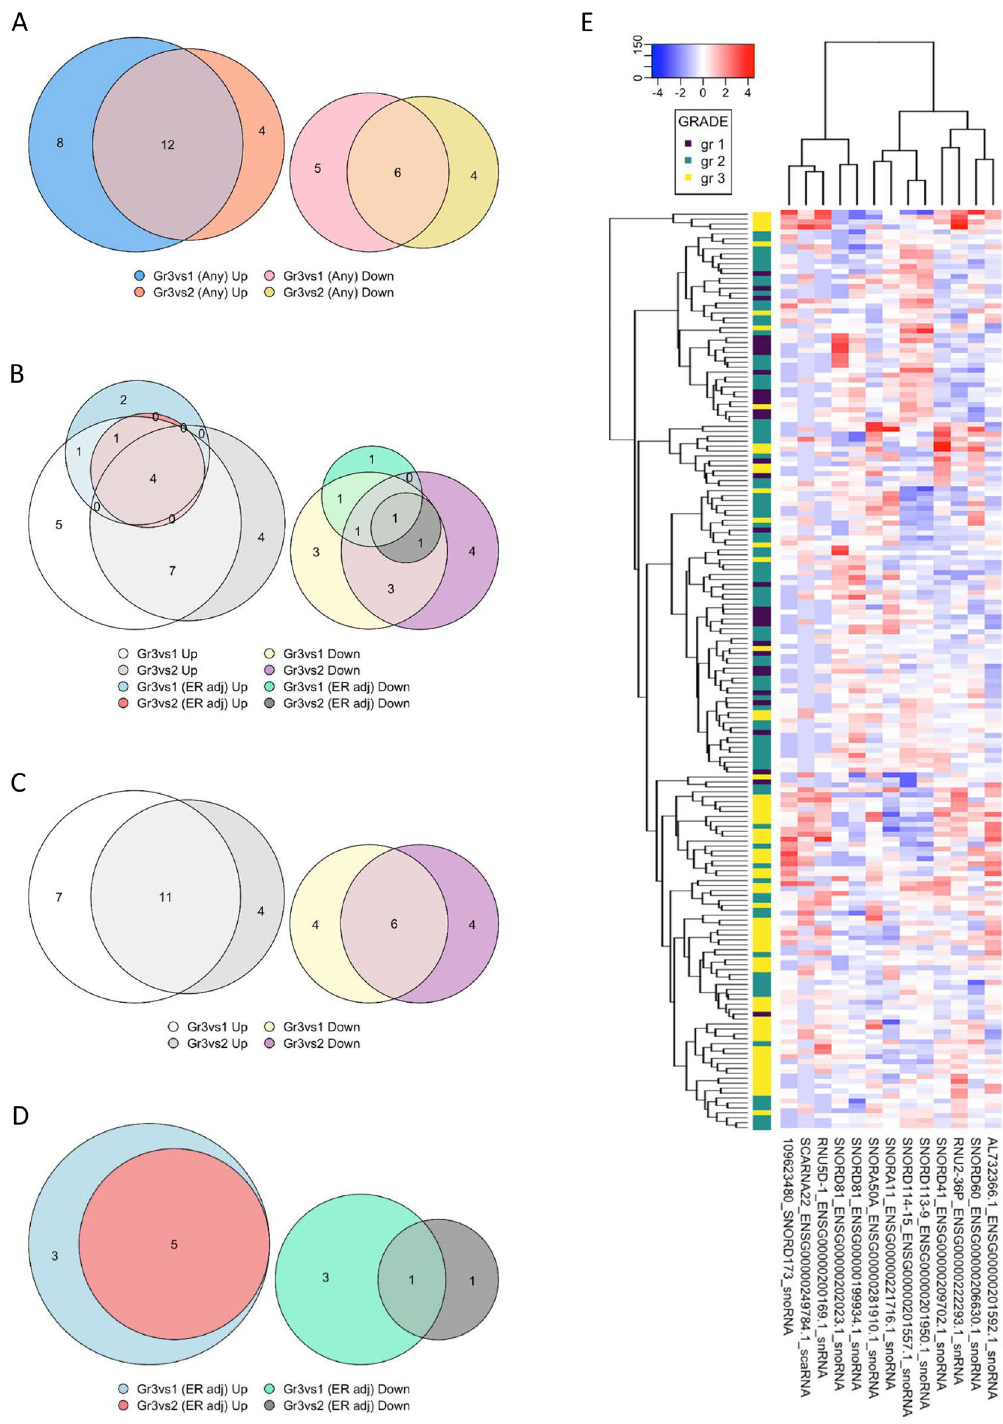
Figure 2. Thirty-nine sncRNAs in total associated ( Padj < 0.01) with the tumor grade in ilBC cases; ( A ) and ( B ) twenty-four sncRNAs were upregulated, and 15 sncRNAs were downregulated in grade III tumors compared to grade I tumors and/or grade II tumors regardless of tumor ER status, ( C ) seventeen were shared in both gr. III versus gr. II, and gr. III versus gr. I when not adjusted for ER status, and ( D ) thirteen sncRNAs were significantly associated ( Padj < 0.01) with the tumor grade independently of the ER status. ( E ) The hierarchical clustering of 186 invasive local BC samples (grade I n = 31, grade II n = 89, grade III n = 66) (columns) and differentially expressed sncRNAs (rows) using Euclidean metrics. Log2 fold change is marked by the color scale (from blue to